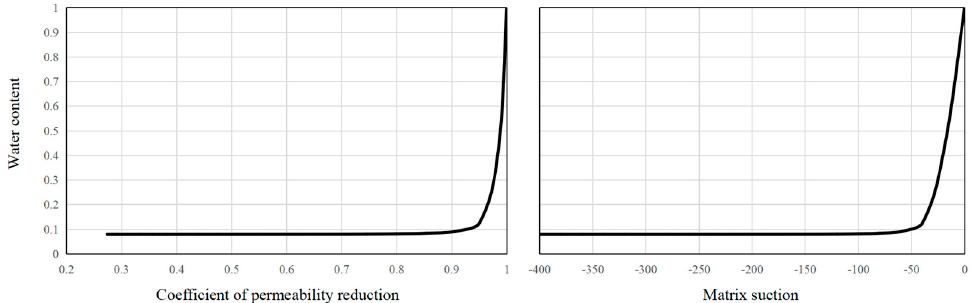
Figure 5. Relationship between coefficient of capability reduction and matrix suction and water content.